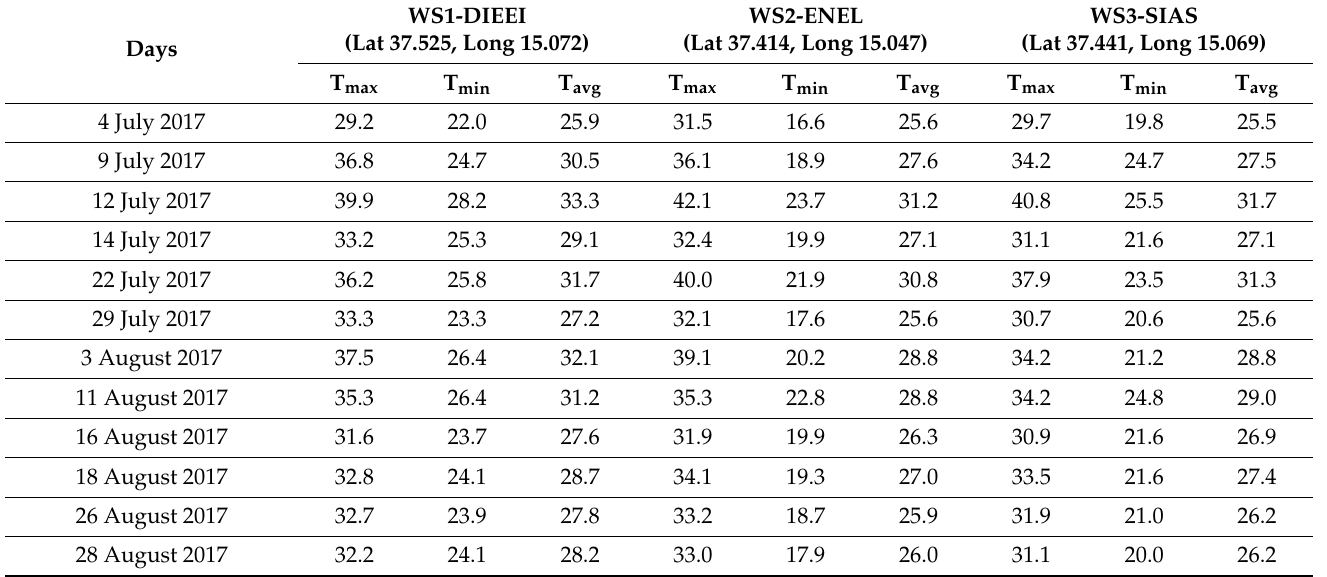
Table 2. Maximum, minimum and average temperatures (T max , T min , T avg ) observed at the three WSs (DIEEI, ENEL, SIAS) during the 12 analyzed days.